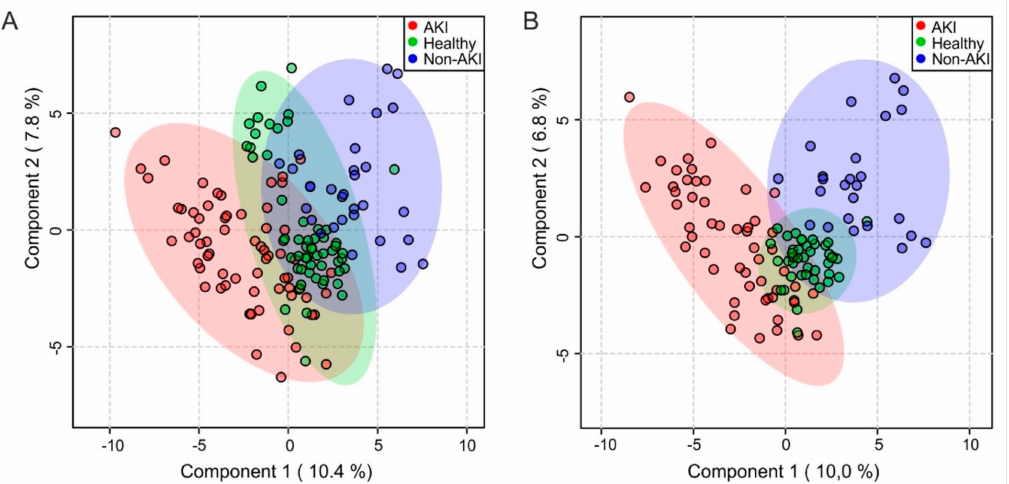
Figure 2. Partial least squares discriminant analysis of the urine spectral bucket table. Neonatal spectra ( A ) included (AKI patients, n = 65; healthy controls, n = 53; non-AKI patients, n = 31), ( B ) excluded (AKI patients, n = 53; healthy controls, n = 42; non-AKI patients, n = 25). AKI, acute kidney injury.